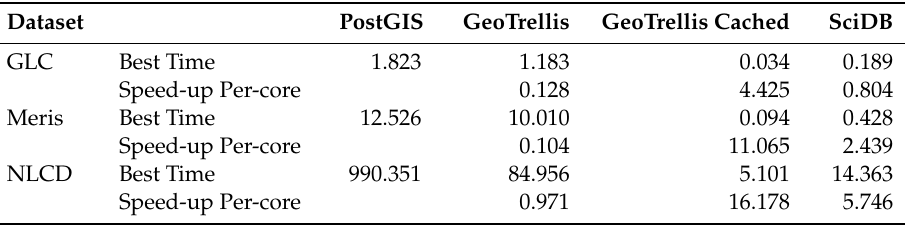
Table 5. Pixel count best time and speed-up for raster datasets.